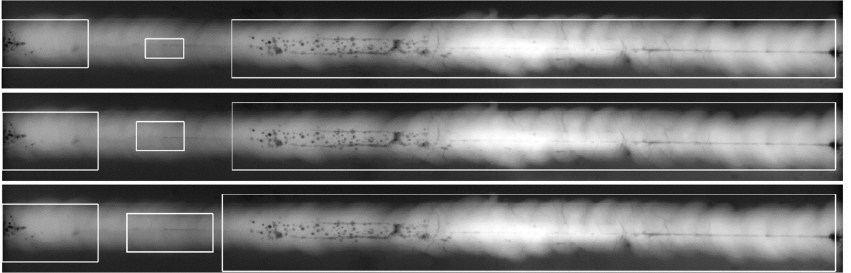
Figure 16. The comparison of detected defects in Image 1 of GDXray dataset [24] by adjusting the threshold parameter θ t (defined in (2)) to be 0.9 ( top row), 0.7 ( middle row), and 0.5 ( bottom row).